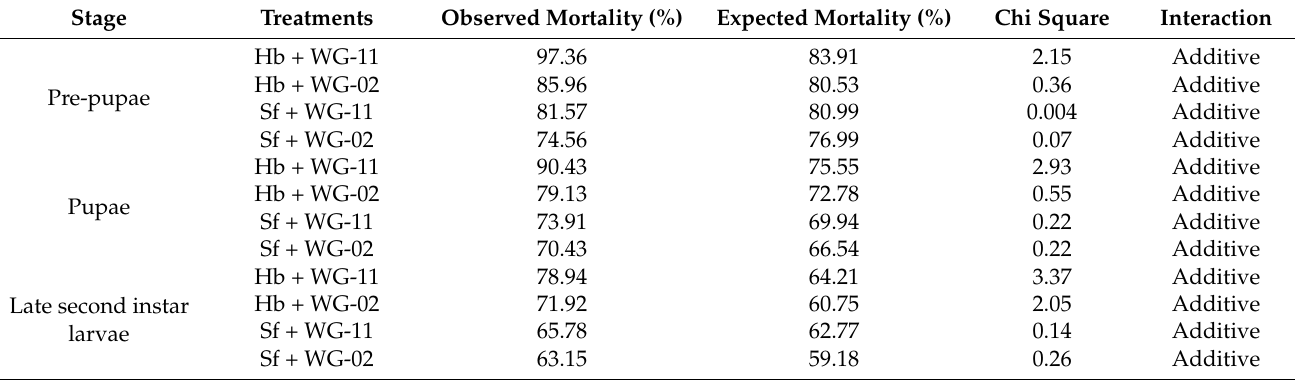
Table 2. Interactions between Heterorhabditis bacteriophora (Hb), Steinernema feltiae (Sf), Beauveria bassiana (WG-11), and Metarhizium anisopliae (WG-02) against late second instar larvae, pre-pupae, and pupae of Thrips tabaci in a laboratory potted soil